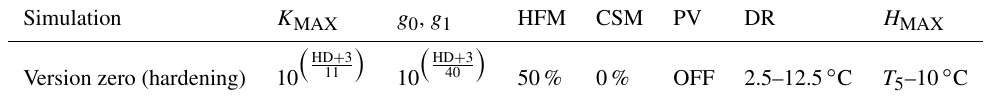
Table 1. Configuration of the version zero simulation. This simulation was run at the sites of Spasskaya Pad and Farstanäs for evergreen needleleaf and deciduous broadleaf trees. T 5 is the 5-year running mean of the minimum 2m daily temperature of each year. Simulation K MAX g 0 , g